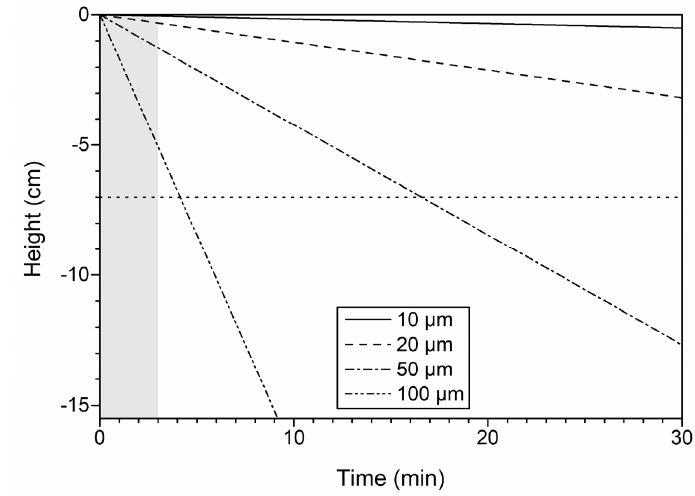
Figure 1. Theoretical position of an exemplary cryomilled polystyrene (PS) particle with a density of Figure 1: Theoretical position of an exemplary PS particle with a density of 1.05 g/cm 3 during settling 144 1.05 g / cm 3 during settling in the course of a measurement with PAMAS particle counter. The particle in the course of a measurement with PAMAS particle counter. Particle starts to sink at the water level. 145 starts to sink at the water level. Height = 0 cm: water level of glass bottle; height = − 15.5 cm: bottom of Height = 0 cm: water level of glass bottle; height = -15.5 cm: bottom of glass bottle. Full, dashed and 146 glass bottle. Full, dashed and dash-dotted lines: theoretical location of particles of di ff erent diameters. dash-dotted lines: theoretical location of particles of different diameters. Horizontal dotted line: 147 Horizontal dotted line: suction height of tubing connected to PAMAS device 7 cm from water surface. suction height of tubing connected to PAMAS device 7 cm from water surface. Highlighted area 148 Highlighted area shows timespan of a measurement (less than 3 min). Stoke’s law with assumption of shows timespan of a measurement (less than 3 minutes). Stoke’s law with assumption of spherical 149 spherical shape was used for shape was used for calculations. 150